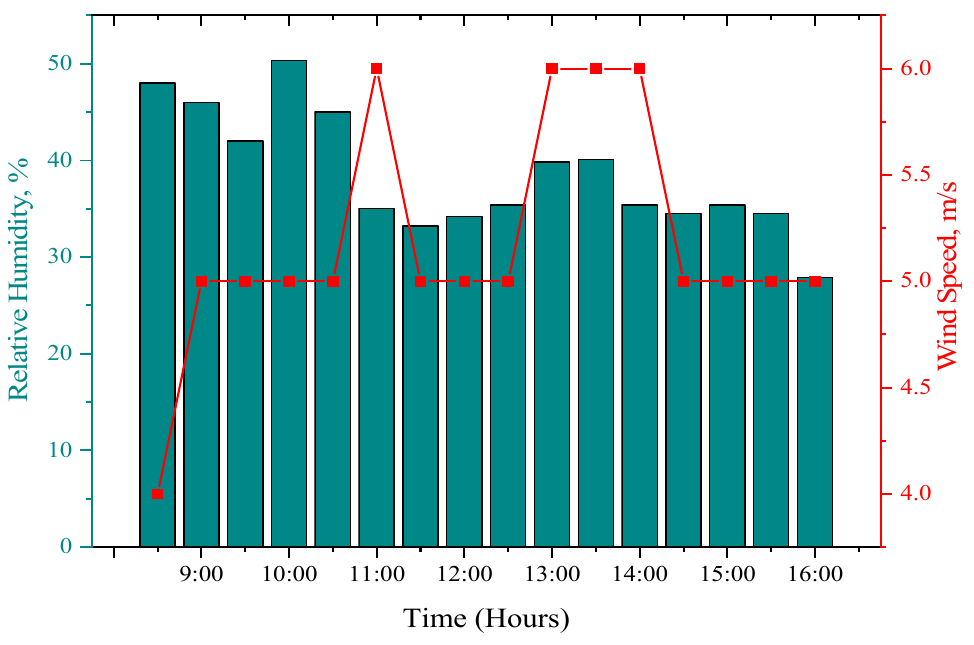
Figure 8. Weather characteristics for the period of the experiment day in relative humidity and wind speed.